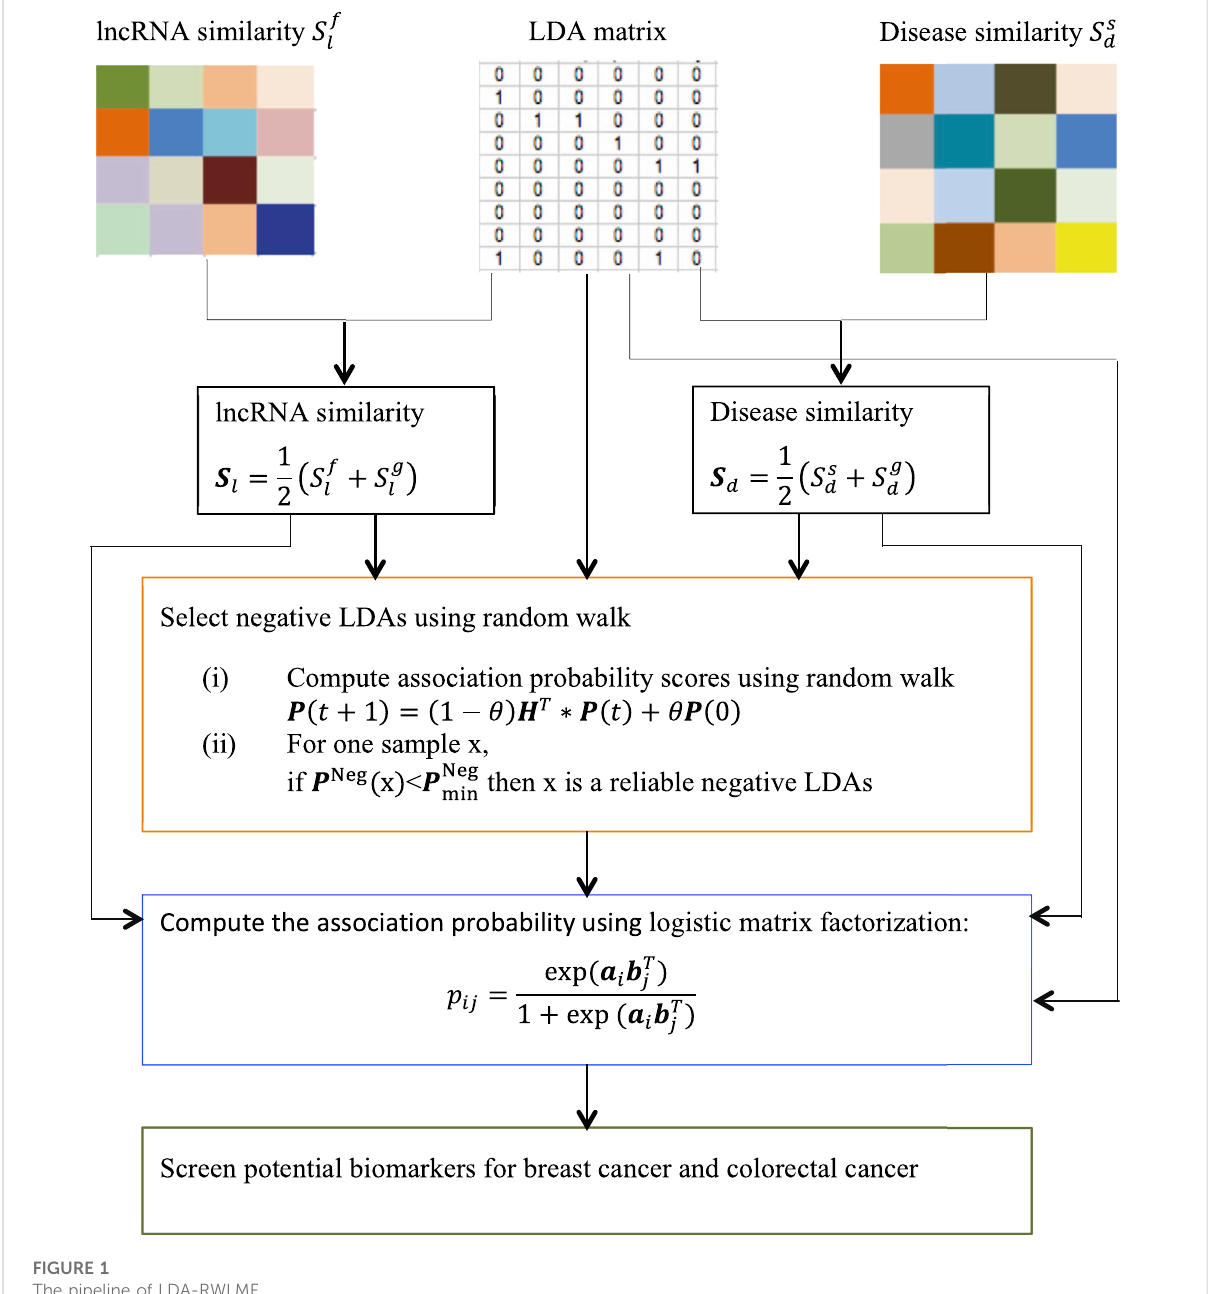
FIGURE 1 The pipeline of